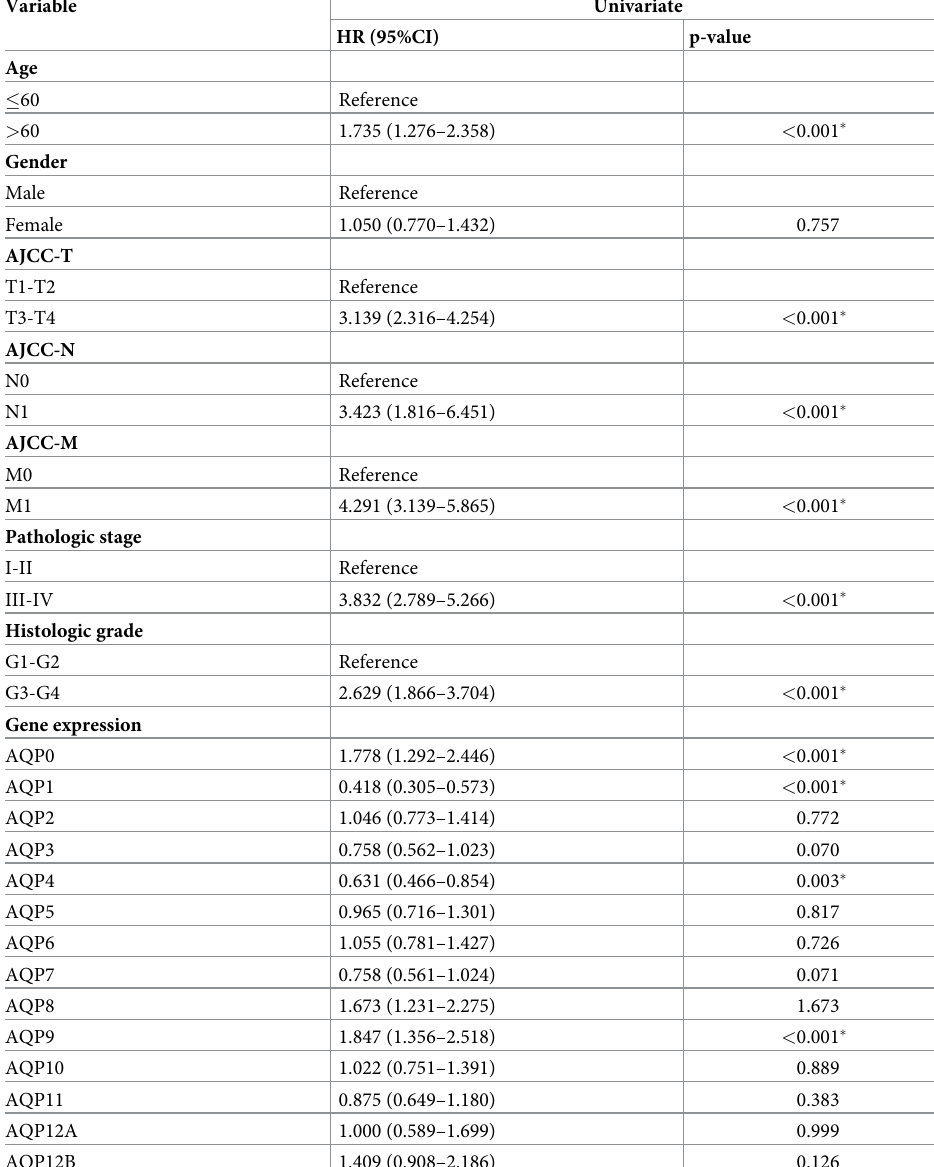
Table 4. Univariate analysis of overall survival in 526 ccRCC